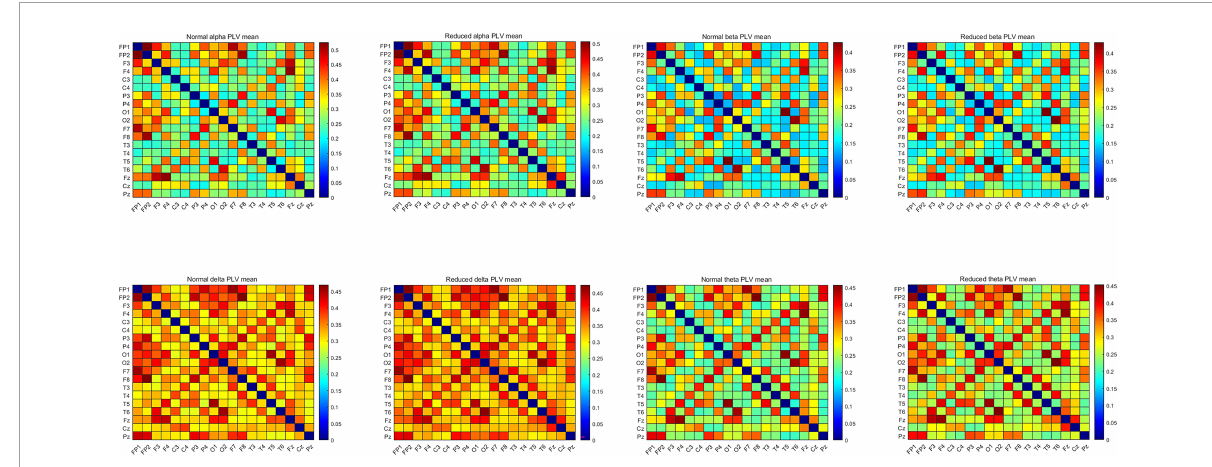
FIGURE2 Mean PLV EEG features in the four frequency bands for the CON and the CI groups of PWEs. PWEs, patients with epilepsy; PLV, phase locking value; CI, cognitive impairment; CON, cognitively